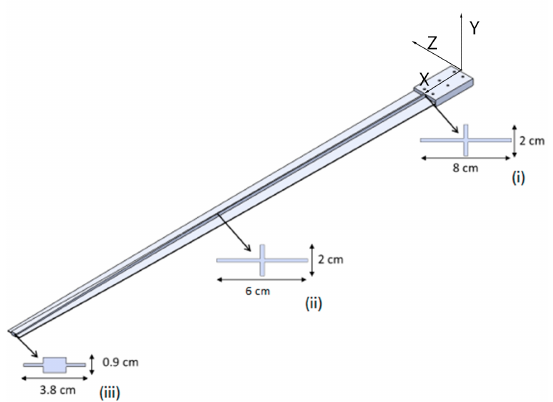
Figure 3. Main spar CAD model with section view at the location of interest: ( i ) root, ( ii ) mid-span, and ( iii ) tip (adapted from